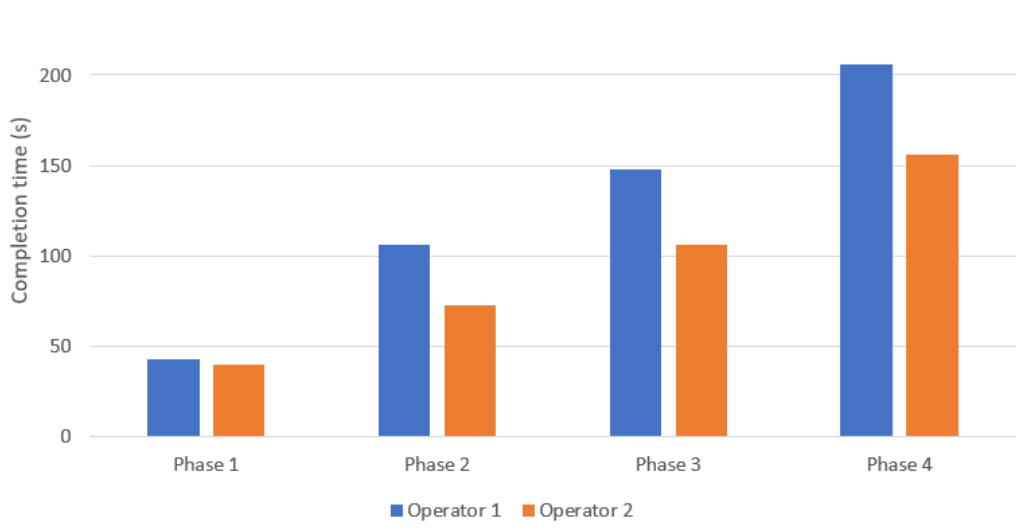
Figure 26. Completion time for two operators during a simulated multi-robot grasping procedure using the grasping detection